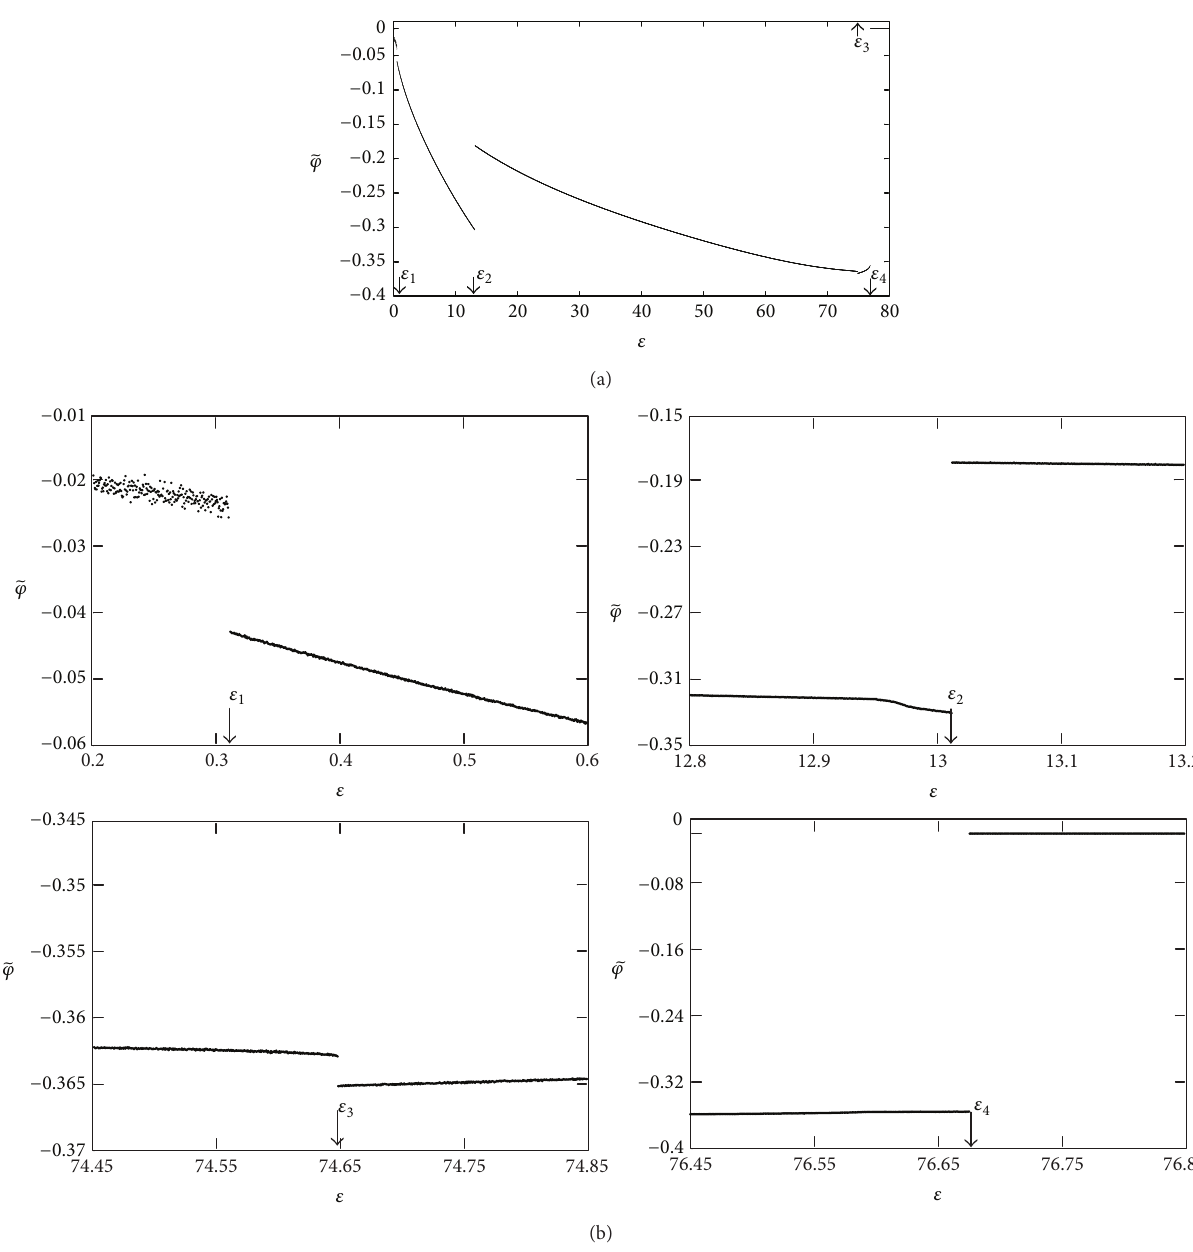
Figure 2: Mean phase ̃𝜑 of the 1st subsystem versus the coupling coefficient 𝜀 . On (b), changes of the ̃𝜑 in the small intervals around 𝜀 1 , 𝜀 2 , 𝜀 𝜀 3 , and 4 are